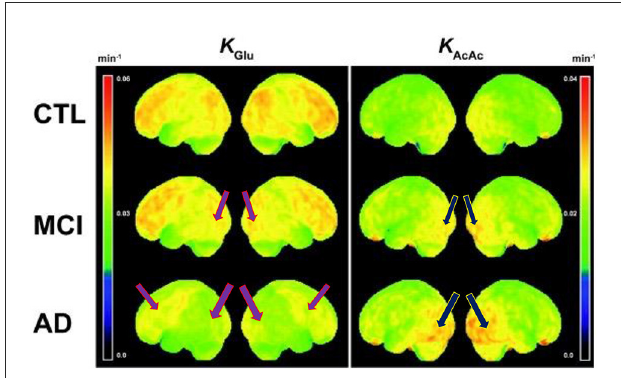
FIGURE2 Voxel-wise 3D surface projection of the brain uptake rate constant for glucose (KGlu; min– 1) and acetoacetate (KAcAc; min– 1) in healthy older controls (CTL; n = 24), mild cognitive impairment (MCI; n = 20) and early Alzheimer’s disease (AD; n = 19). Note the worsening reductions in glucose metabolism from control to MCI and most severe reductions in AD (left column images). Despite these glucose metabolic reductions, there is preserved to even increased ketone body uptake (right column images), that is more prominent in AD compared to MCI. Purple arrows represent reduced glucose metabolism and blue arrows represent increased ketone metabolism. These findings indicate that reduced glucose metabolism in MCI and AD still reflects the presence of viable neurons and glial cells. Figure reproduced with permission from Croteau et al. (9).